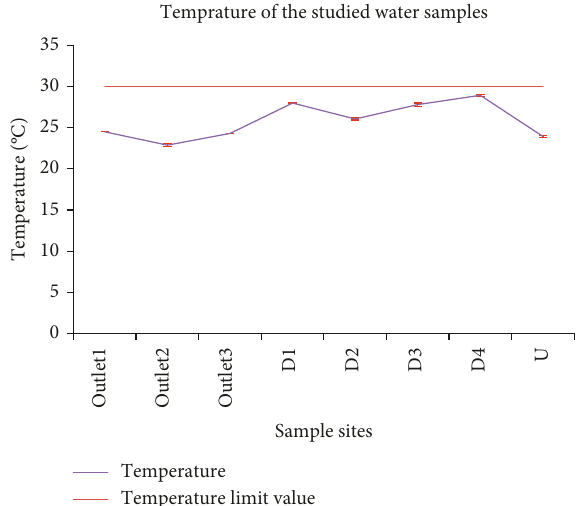
Figure 3: Comparison of temperatures of wastewater from the Zenzelma campus and the WHO recommended maximum tem- perature limit in wastewater.